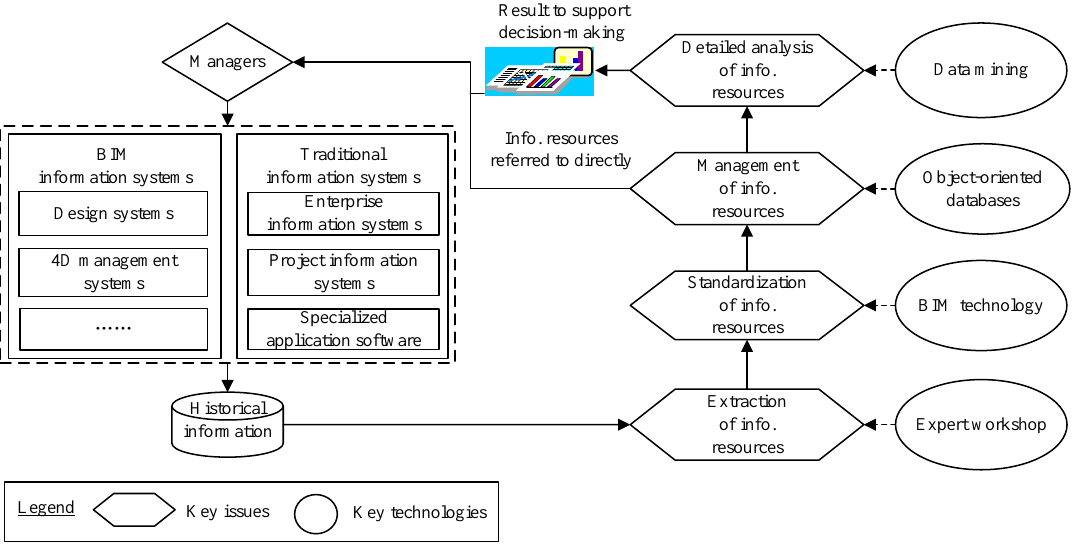
Figure 1 Conceptual framework for reusing construction firm’s information resources (Ma